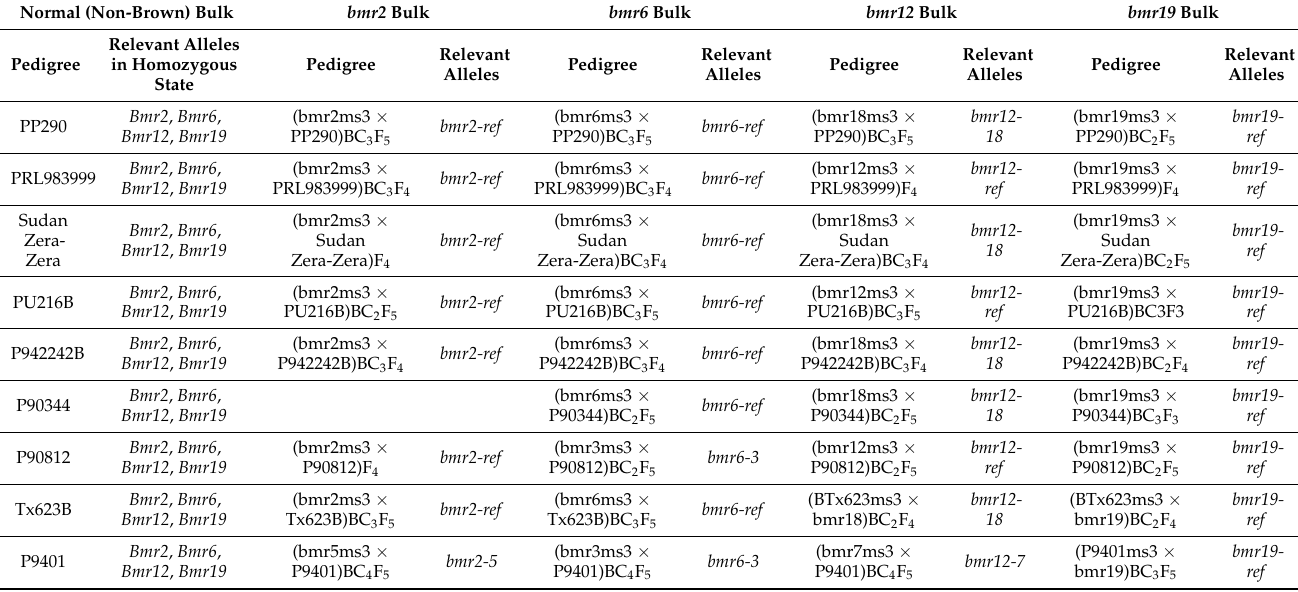
Table 1. Constitutions of the resequenced bulks and pedigrees of brown midrib introgression